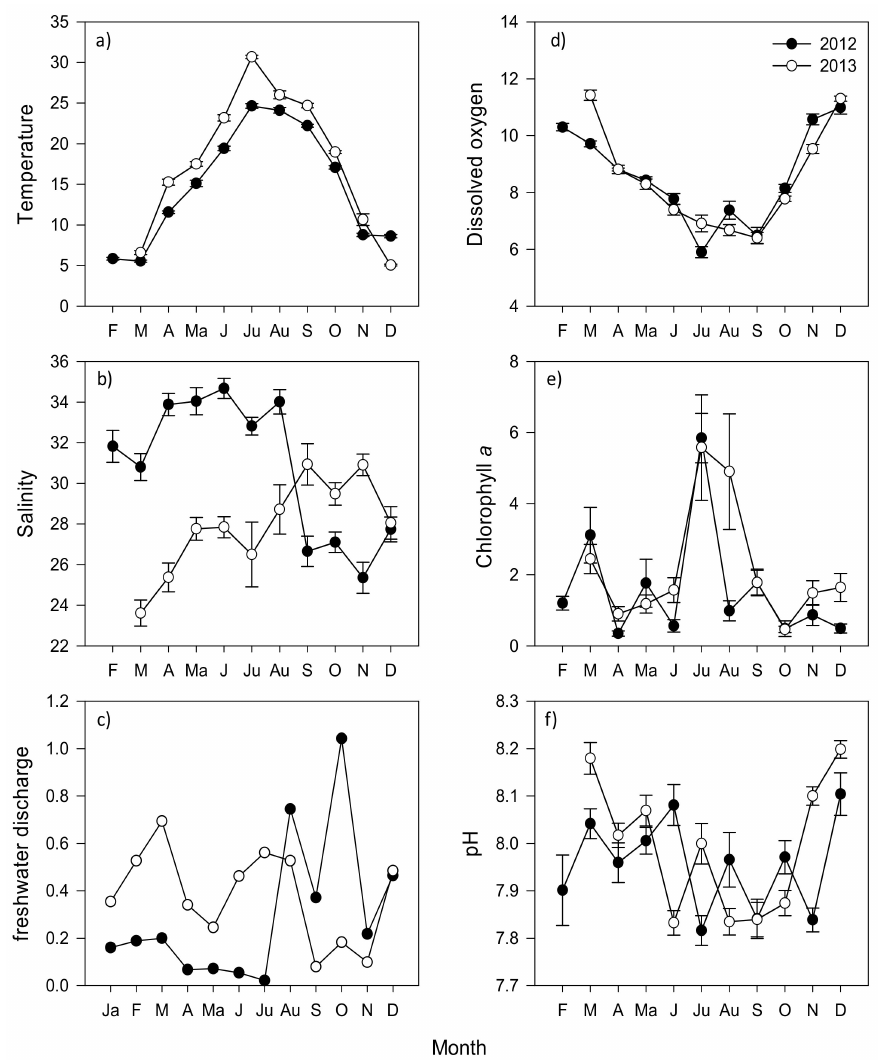
Figure 2. Seasonal patterns of environmental variables expressed as mean values ± SE: ( a ) Temperature ( ◦ C); ( b ) salinity; ( c ) Freshwater discharge (m 3 s − 1 ); ( d ) dissolved oxygen (mg L − 1 ); ( e ) Chlorophyll- a ( µ g L − 1 ); and ( f )